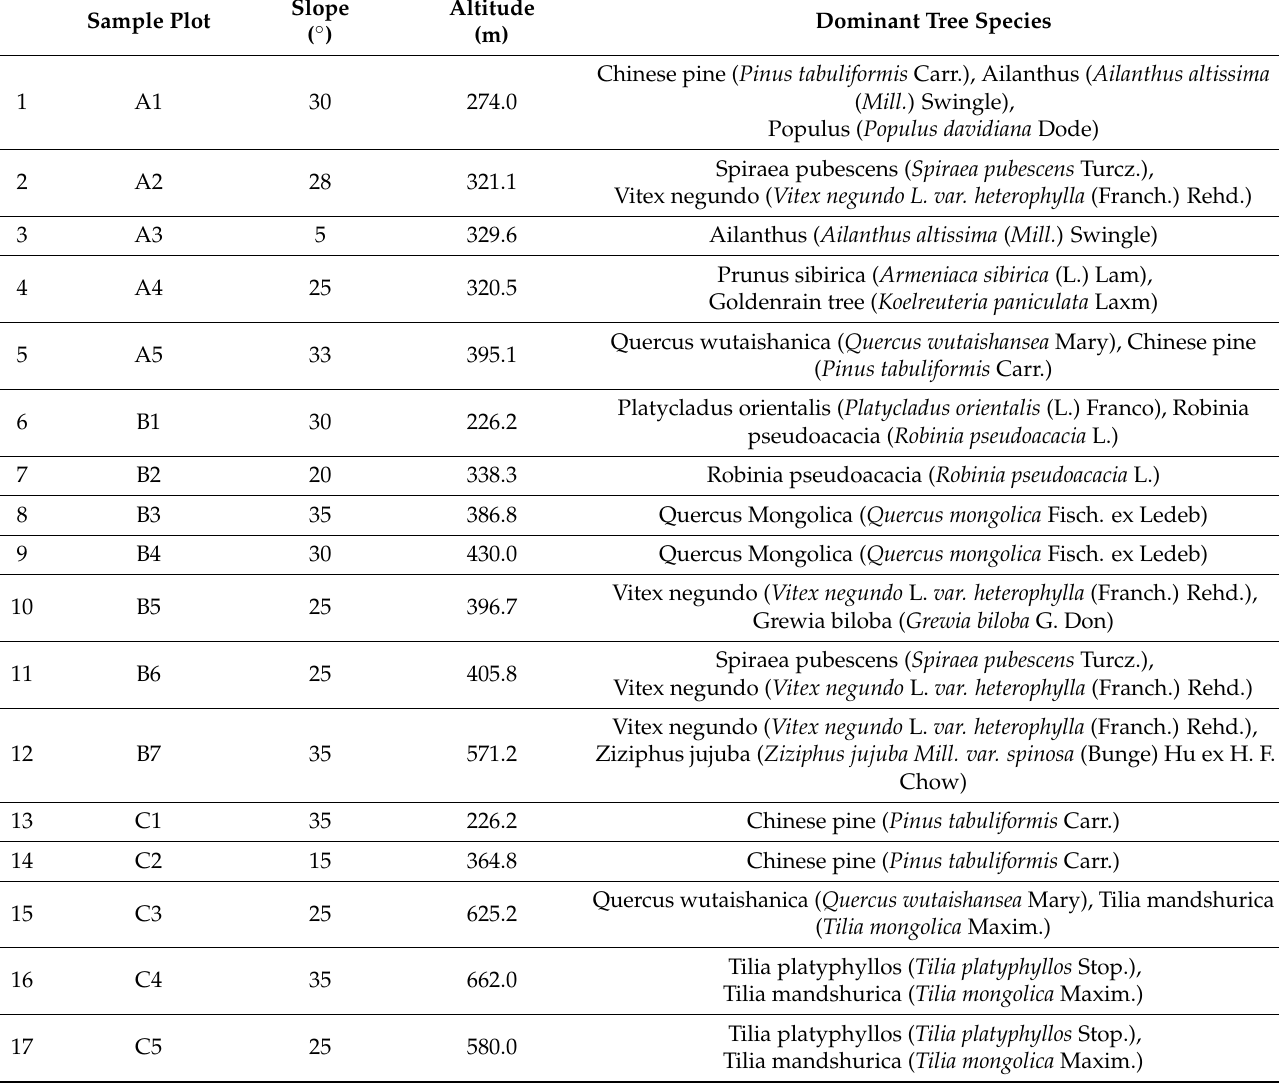
Table 1. Basic information of the 22 selected sample